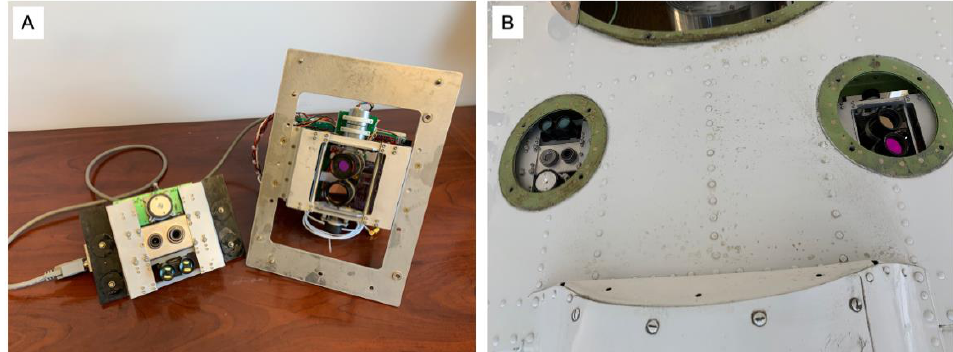
Figure 9. For integration on an NOAA Twin Otter aircraft, the AWSM instrument suite was split into two parts ( A ) and installed to use two 11 cm diameter ports ( B ) in the aft payload bay.